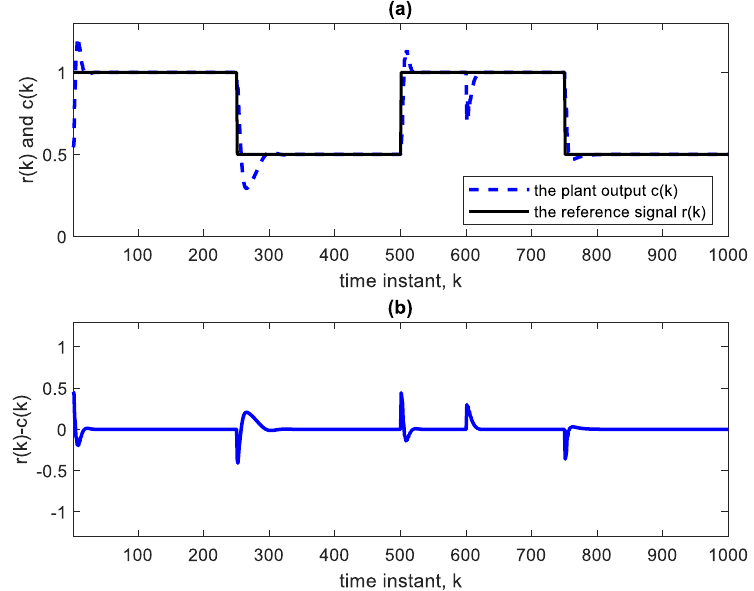
Figure 6. ( a ) Reference and plant output with a parameter change at the 600th sample according to Equation (7), using Ɲ (𝟒,𝟏):𝟓:𝟓:𝟓:𝟓 . ( b ) Error curve r(k)-c(k).